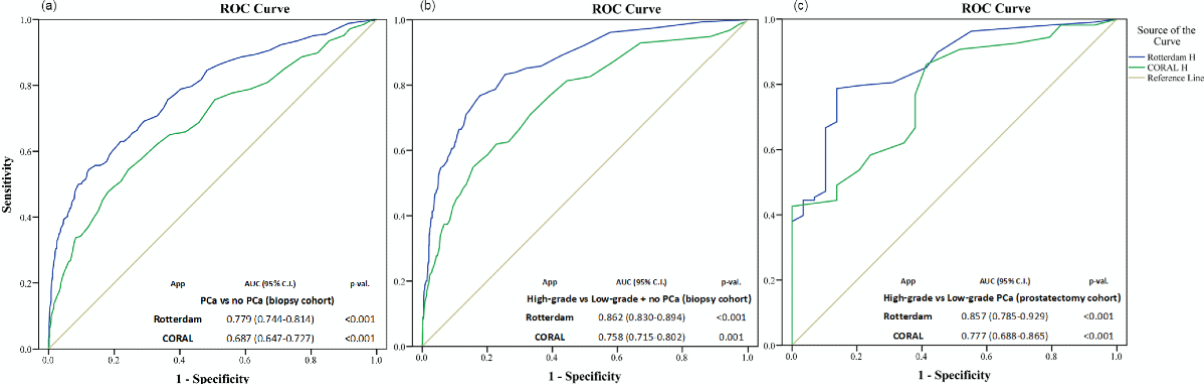
Figure 3. Receiver operating characteristic (ROC) curves and areas under the receiver operating characteristic curves (AUCs) for the discriminative ability of the Rotterdam and Coral apps. (a) Prostate cancer (PCa) vs no PCa in the biopsy cohort; (b) high-grade PCa vs low-grade PCa plus no PCa in the biopsy cohort; (c) high-grade PCa vs low-grade PCa in the prostatectomy